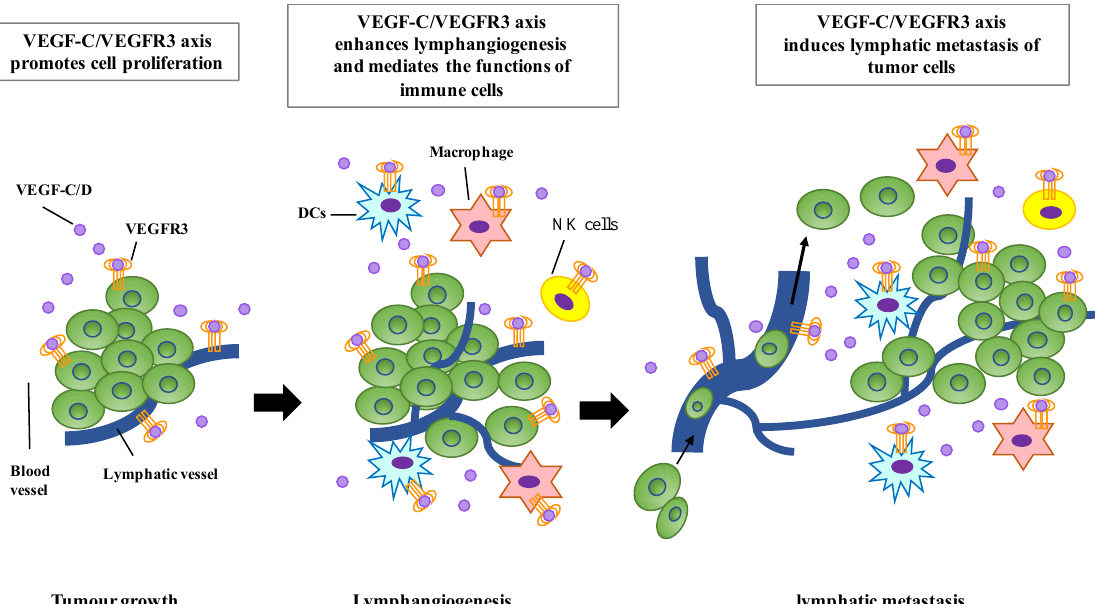
Figure 2. The function roles of VEGF-C/VEGFR3 signaling in tumor progression. The VEGF-C/VEGFR3 axis promotes tumor growth in autocrine and paracrine manners. VEGF-C can enhance the proliferation of LECs through VEGFR3, resulting in lymphangiogenesis and lymphatic metastasis of tumor cells. VEGF-C/VEGFR3 signaling can also mediate the functions of immune cells, including dendritic cells (DCs), macrophages, and natural killer (NK) cells.